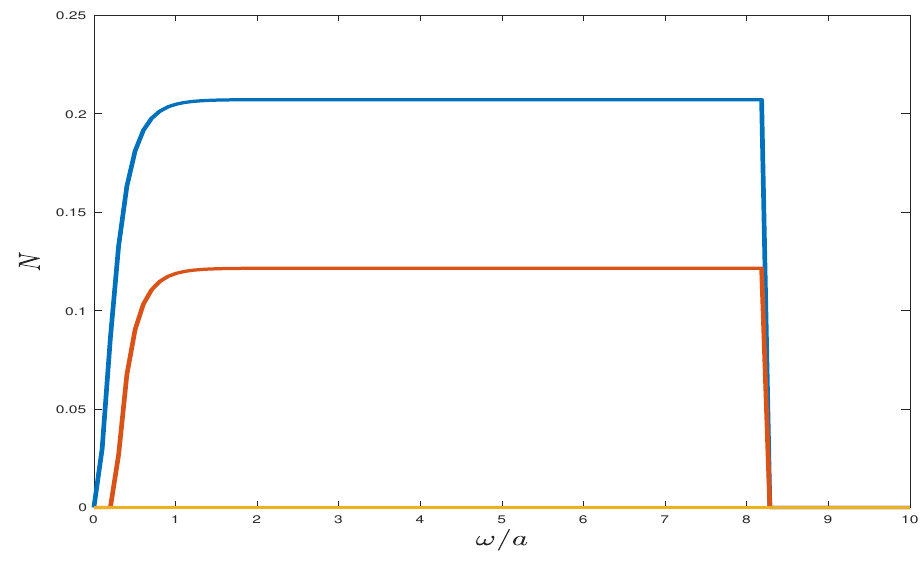
Figure 10 . The change of N with ω for different initial states, with α = 0 for the blue line, α = 0 . 1 √ for the red line, and α = 1 / 2 for the yellow